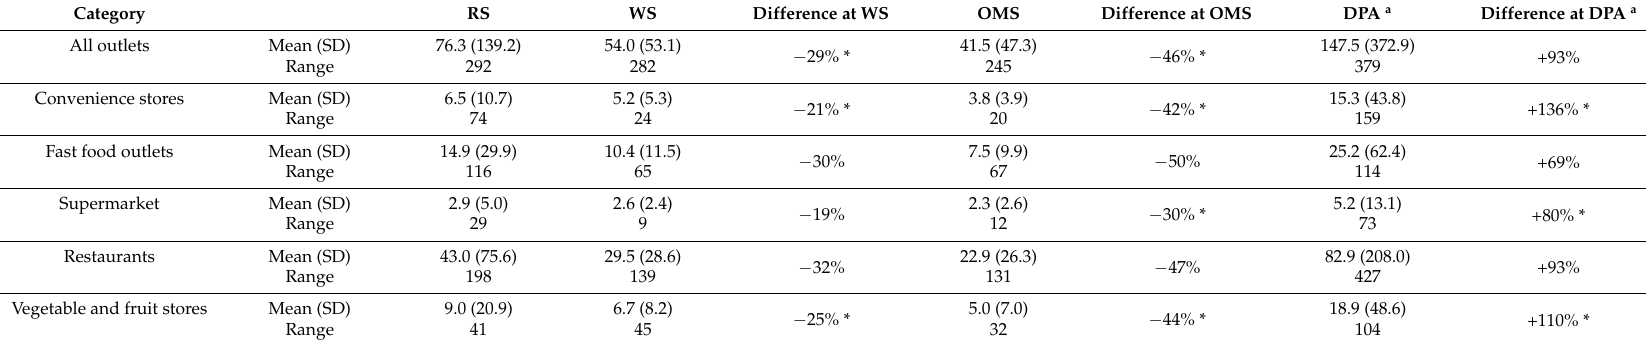
Table 2. Descriptive statistics of food outlets counts in residential space, workspaces, other major spaces, and commuting path areas ( n =